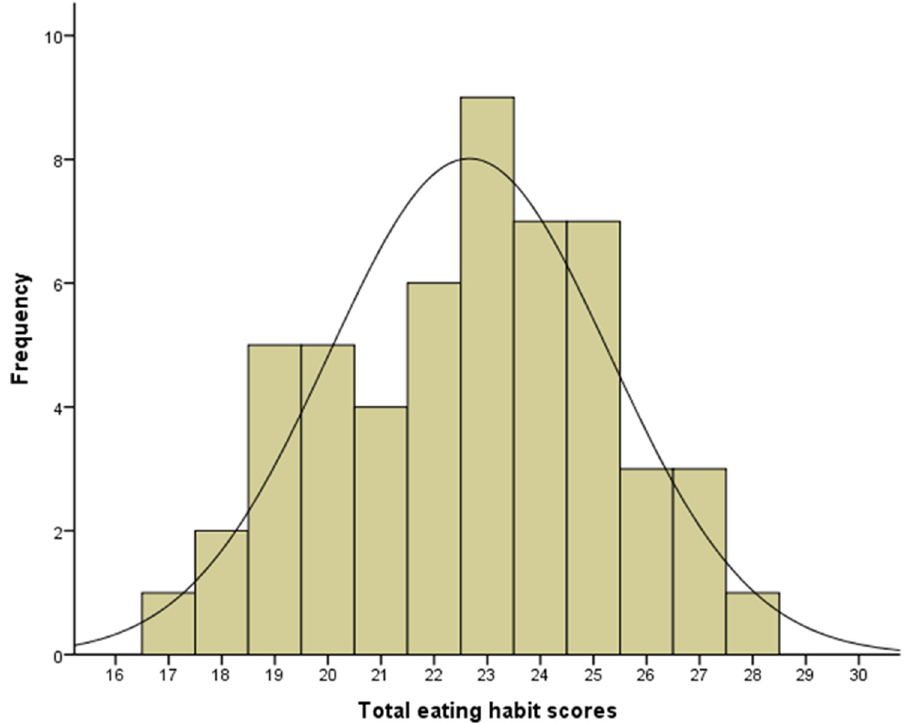
Fig 1. Total scores (mean ± standard deviation: 22.7 ± 2.6, median: 23.0, mode: 23.0, range: 17–28) among participants, showing an almost normal distribution.